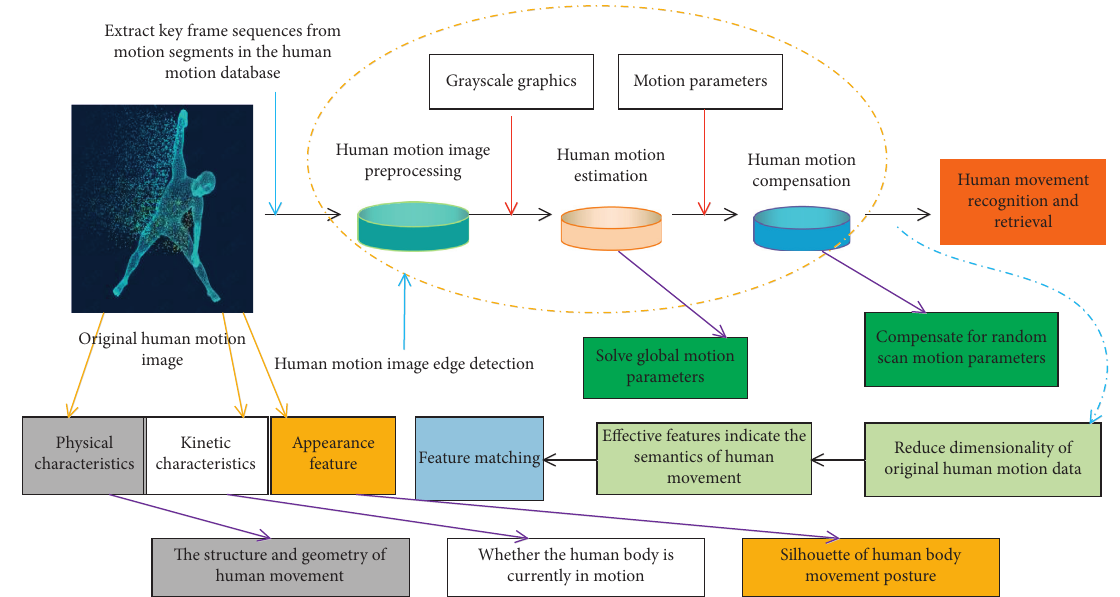
Figure 1: Visual feature collection and feature extraction of human